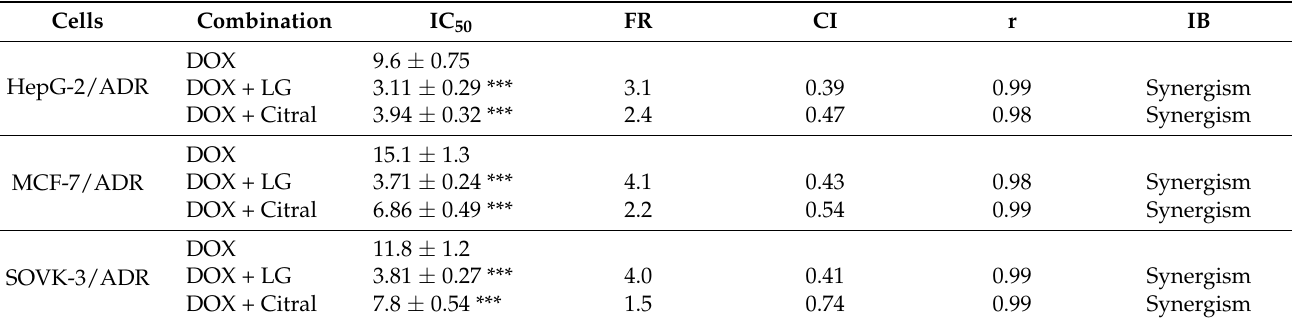
CI; combination index, FR; fold reversal, IB; isobologram, and medium effect equation (r-value). *** for p < 0.001 comparing to IC 50 values of